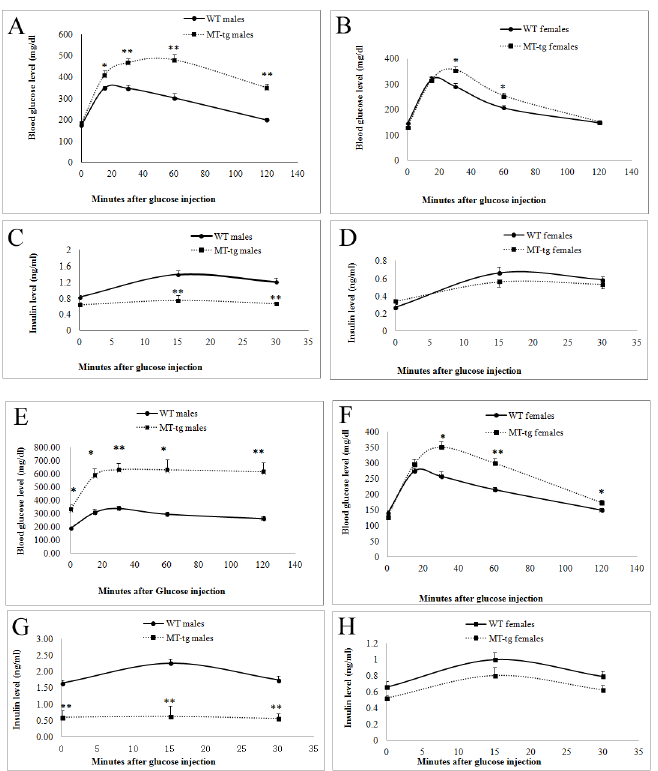
Fig 3. Glucose tolerance tests (GTT) and plasma insulin levels during GTT in 8- and 18-week-old MT- tg and WT mice. ( A, C) 8-week old MT-tg (n = 10) and WT (n = 14) male mice; (B, D) 8-week old MT-tg (n = 8) and WT (n = 10) female mice; (E, G) 18-week old MT-tg (n = 5) and WT (n = 5) male mice; (F, H) 18-week old MT-tg (n = 8) and WT (n = 10) female mice. * p < 0.05, ** p < 0.01 vs WT.